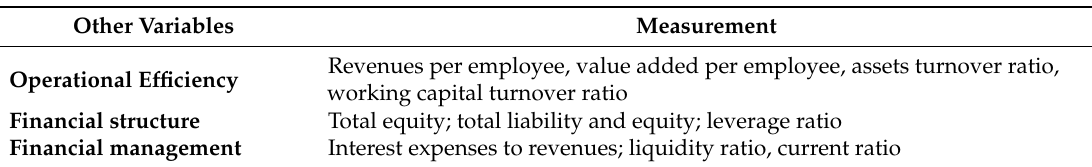
Table 4. Other variables.